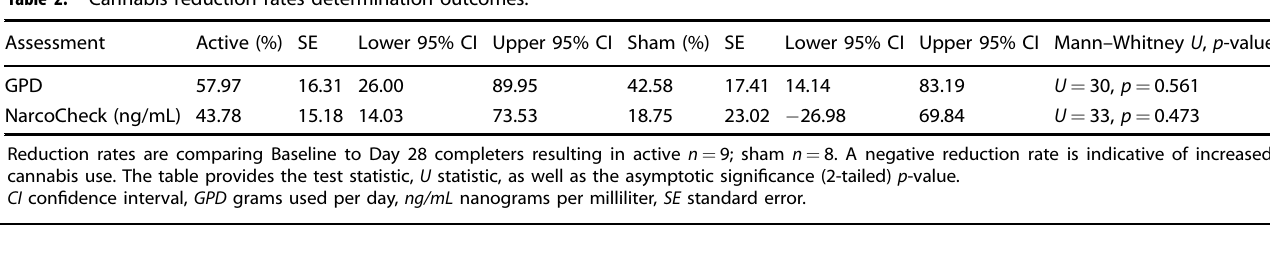
Table 3. Change in cannabis use from baseline to Day 28 in active compared to sham treatment.